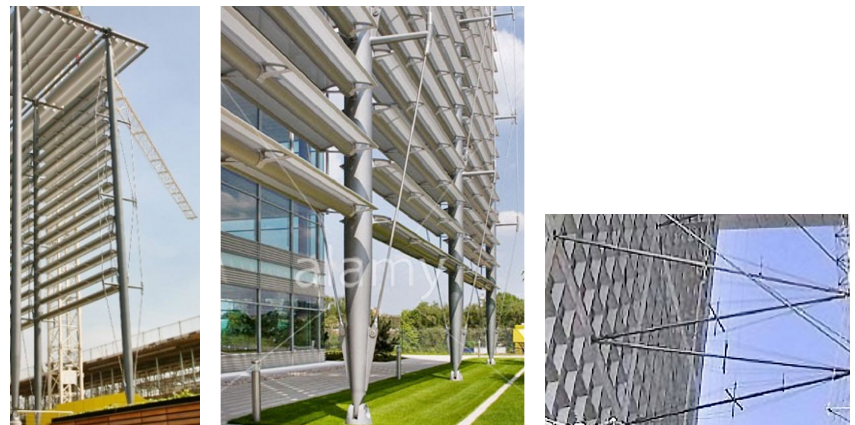
Fig. 1. Stayed members in London (left and middle), supports of Grande Arche lift in